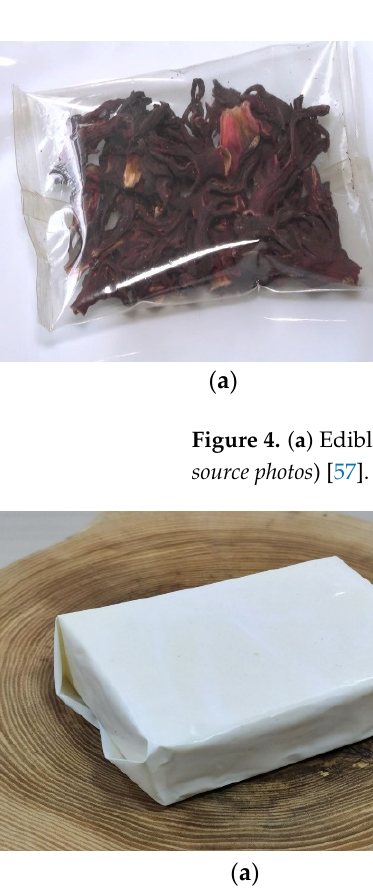
Figure 5. ( a ) Biodegradable eggshell packaging for food; ( b ) biodegradable eggshell labels for bottles ( Open source photo ) [57].